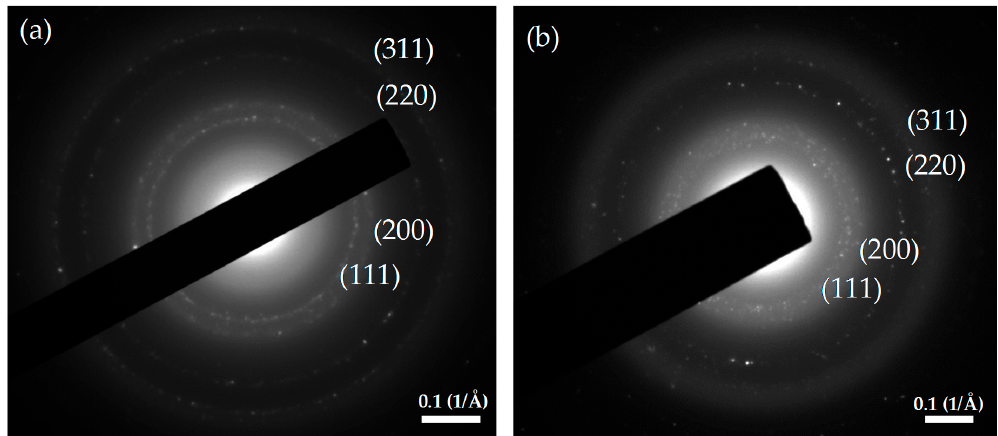
Figure 10. Selected area of electron diffraction (SAED) pattern from one of the AgNPs produced by: ( a ) WLC-1.250 mM; and ( b ) EPS-S-1.250 mM.